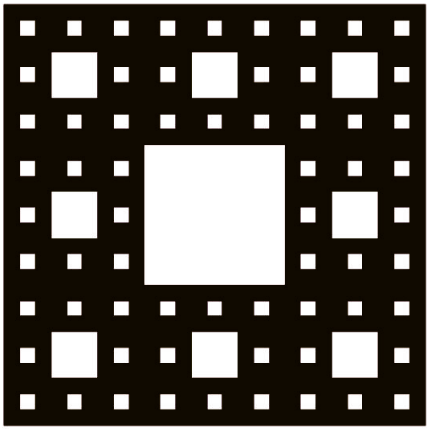
Figure 2. Third iteration of the Sierpinski carpet.